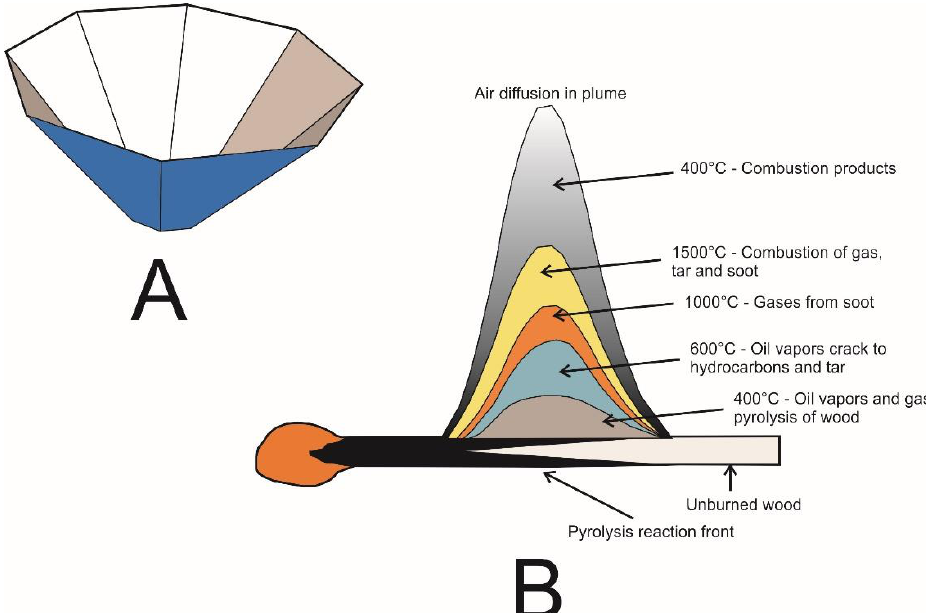
Figure A4. The Kon Tiki kiln is the metal funnel represented in ( A ). Here, the woody biomass is placed and burned. During the burning, the reactions described in ( B ) occur, thereby leading to the production of biochar. The image of the Kon Tiki kiln was modified from https://www.biochar-journal.org/en/ct/39 (accessed on 21 March 2021), while the image of the reactions was adapted from http://www.allpowerlabs.com/gasification-explained (accessed on 21 March 2021).